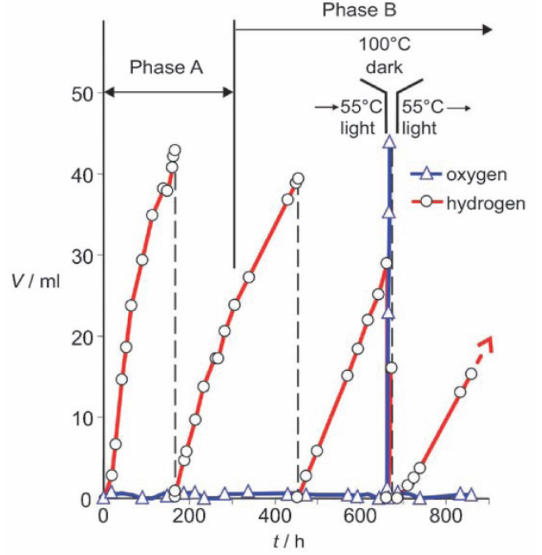
Figure 15. The representative reaction of TiSi 2 at 328 K under standard conditions. Reproduced